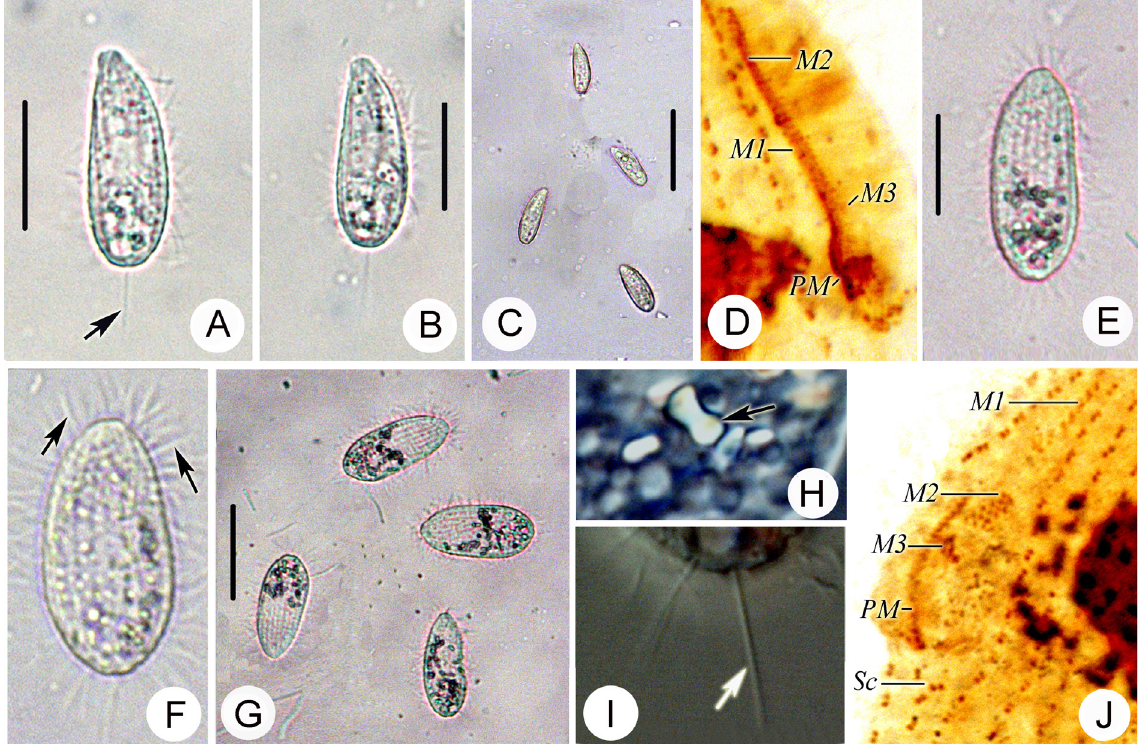
Fig. 3. A – D . Pseudocohnilembus hargisi Evans & Thompson, 1964. E – J . Parauronema cf. longum Song, 1995. A–C, E–I. In vivo . D, J. After silver impregnation. A , E . Ventral views of typical individuals, arrow in (A) shows caudal cilia. B – C , F – G . Different individuals, showing varying body shapes, arrowheads in (F) mark somatic kineties. D , J . Detailed structure of the buccal area. H . Ventral view, arrow refers to dumbbell-shaped crystals. I . Posterior end, arrow marks caudal cilium. Abbreviations: M1, 2, 3 = membranelle 1, 2 and 3; PM = paroral membrane; Sc = scutica. Scale bars: A–B = 15 μ m; C, E = 40 μ m; G = 60 μ